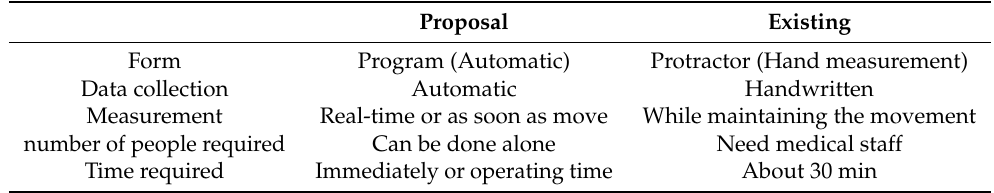
Table 5. The difference from the existing